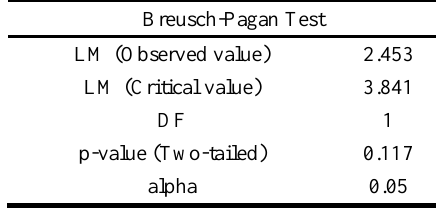
Table 7. Breusch-Pagan Test